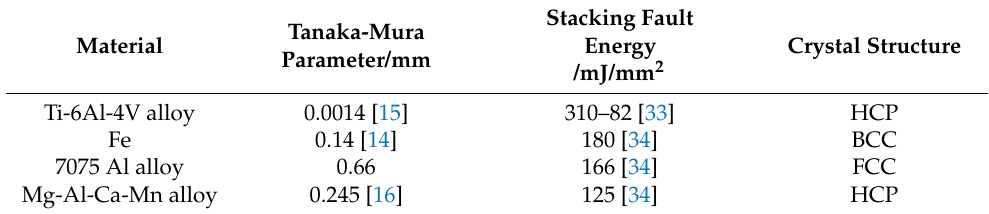
Stacking Fault Crystal Structure Energy /mJ/mm 2